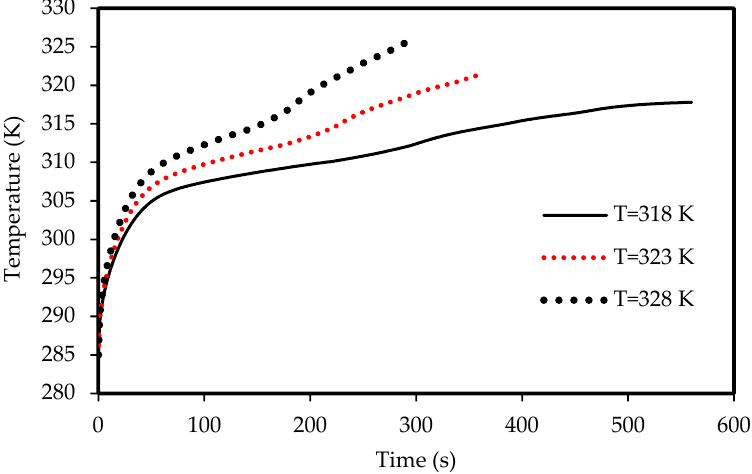
Figure 21. Evolution of the liquid-fraction of the melting process in the horizontal corrugated channel for different airflow temperatures.